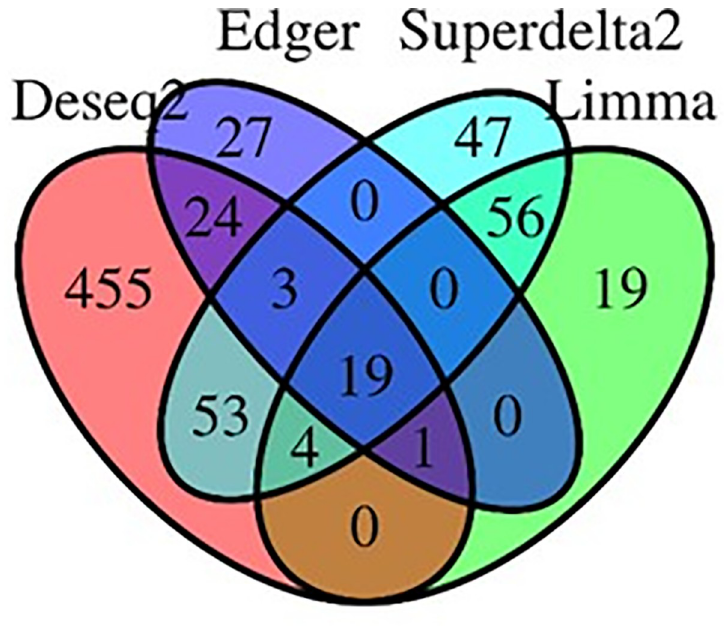
Fig 2. Venn diagram of DEGs. Four different methods (DESeq2, edgeR, limma, and Superdelta2) were utilized generating 19 common differentially expressed genes.